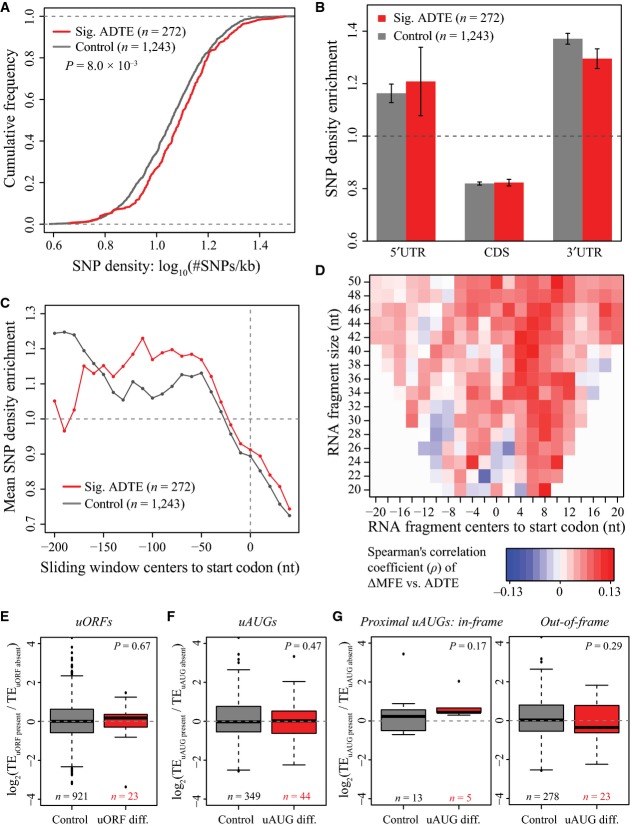
Sequence features that were correlated with ADTE, based on the ribosome footprinting data.A–G Panels are the same as Fig3A–G, but based on ribosome footprinting data.